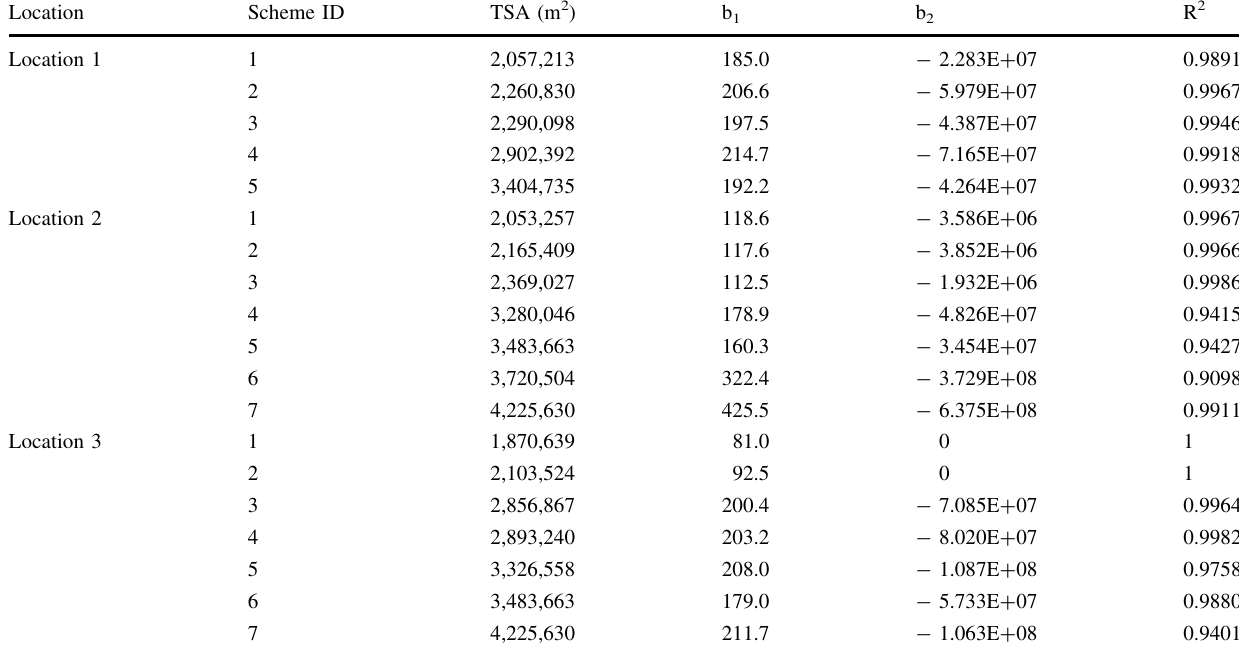
Table 3 Estimated parameter values of total weighted evacuation time (TWET) and evacuation population relationship for different total shelter area (TSA) and community location scenarios